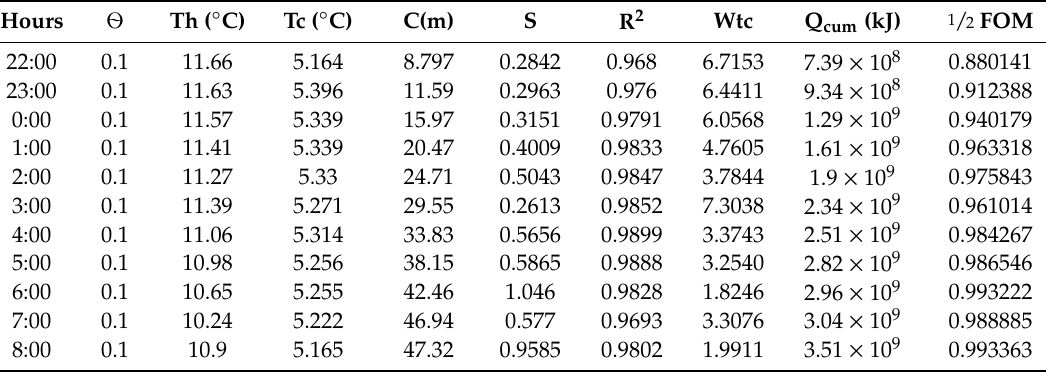
Table A3. 3rd–4th January 2019 Curve Fitting and Performance Parameter